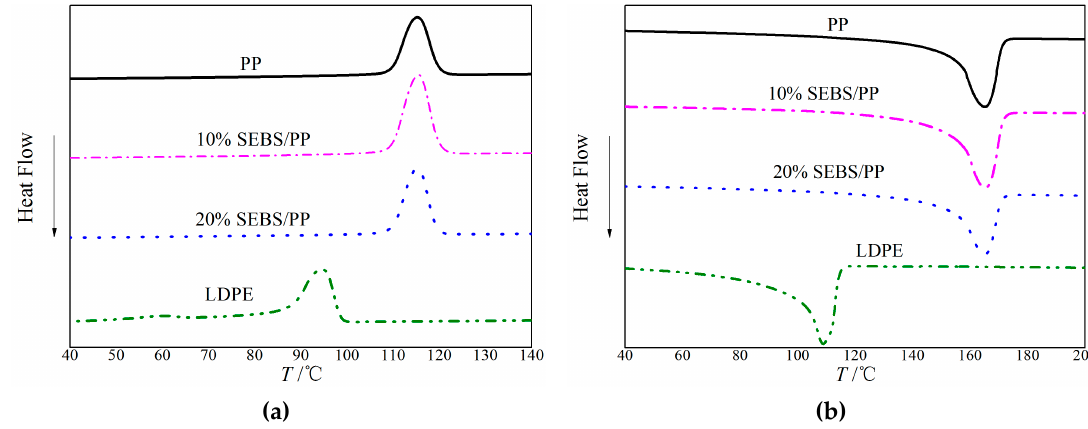
Figure 5. Differential scanning calorimetry (DSC) temperature spectra of the SEBS/PP composites Figure 5. Di ff erential scanning calorimetry (DSC) temperature spectra of the SEBS / PP composites and and LDPE for the ( a ) crystallizing and ( b ) melting processes. LDPE for the ( a ) crystallizing and ( b ) melting Table 1. Crystallization temperature T c , melting temperature T m and crystallinity X c of PP, LDPE and SEBS/PP composites.